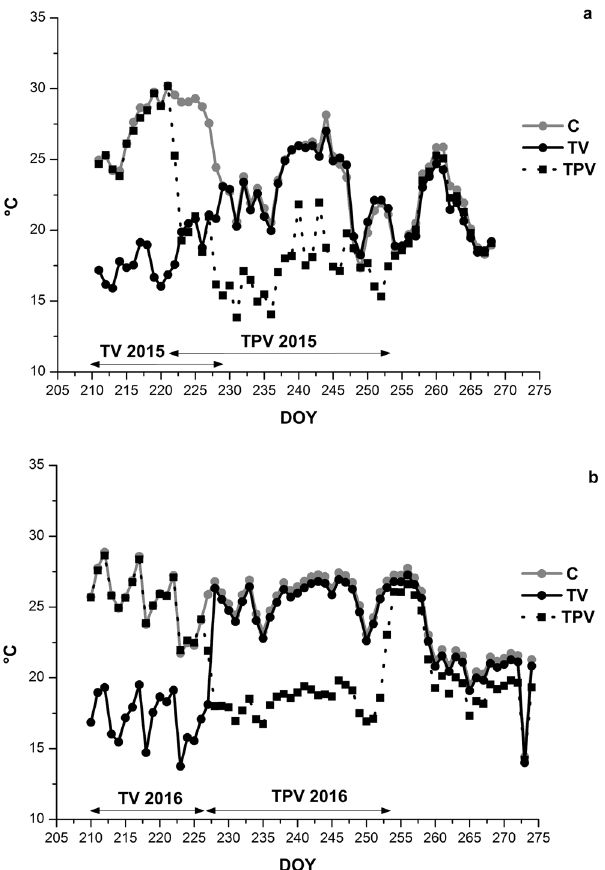
Figure 2. Trends in mean berry temperature for Corvina vines treated at low temperature in the night (TV and TPV) and for the control (C), from the beginning of the experiment (pre-veraison) to harvest in 2015 ( a ) and 2016 ( b ) seasons. The duration of the low night temperature treatments during veraison (TV) or post veraison (TPV) periods is indicated by black double